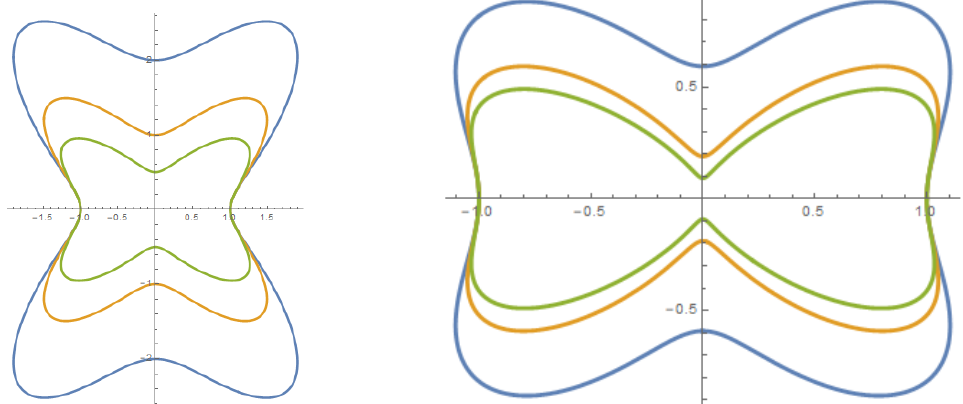
Figure 3: model class 2. left: contour curves of the density in the cases a = −2, b = 1.5, 2, 3, c = 1, β = 0 . right: contour curves in the cases a = −0.7, b = 1, 2, 3, c = 2, β =